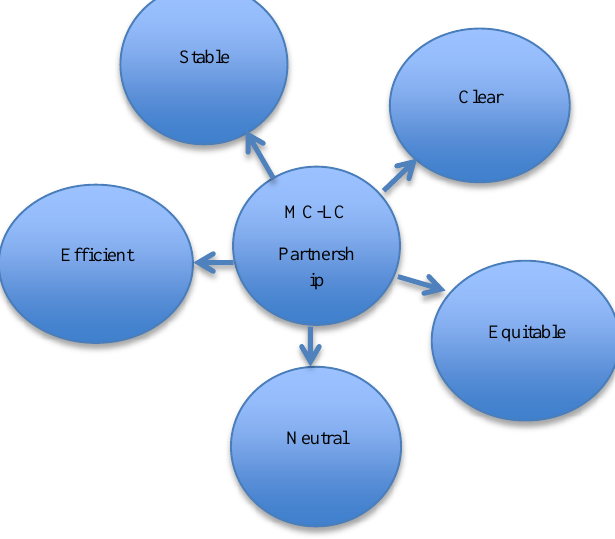
Fig. 1: Wheel of sustainable development partnership agreement; Source : Zvarivadza,